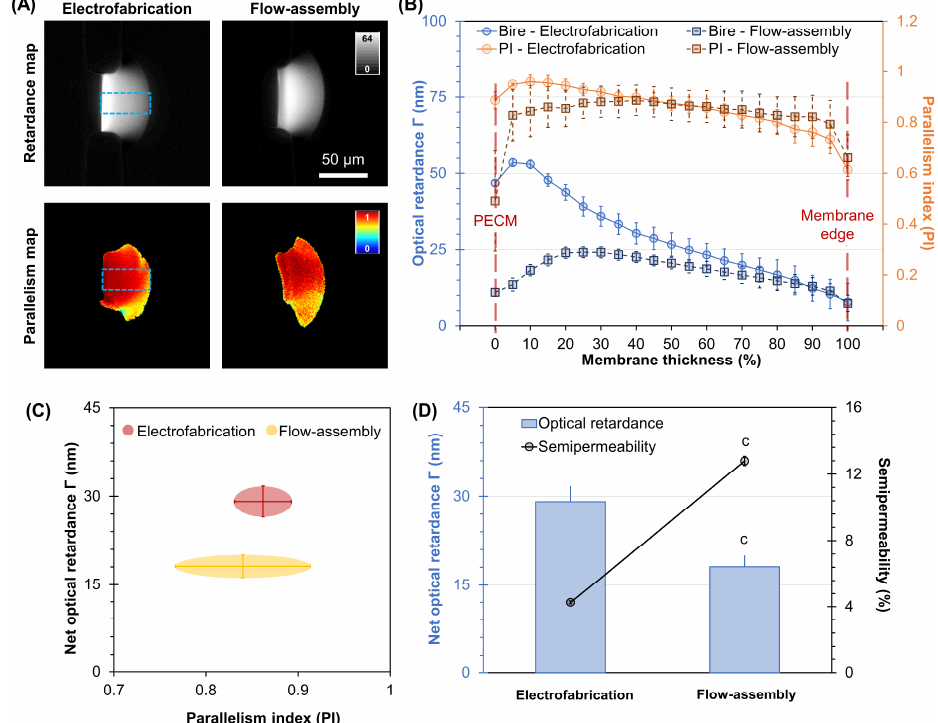
Figure 6. Optical properties comparison between electrofabricated and flow-assembled chitosan membranes. ( A ) Retardance and parallelism index (PI) maps of electrofabricated and flow-assembled chitosan membranes. ( B ) Profile plots of optical retardance and PI across chitosan membranes formed with electrofabrication and flow assembly. Correlations between net optical retardance with ( C ) PI and ( D ) semi-permeability of both types of chitosan membranes. Results of pairwise comparisons are indicated by c ( p < 0.001).